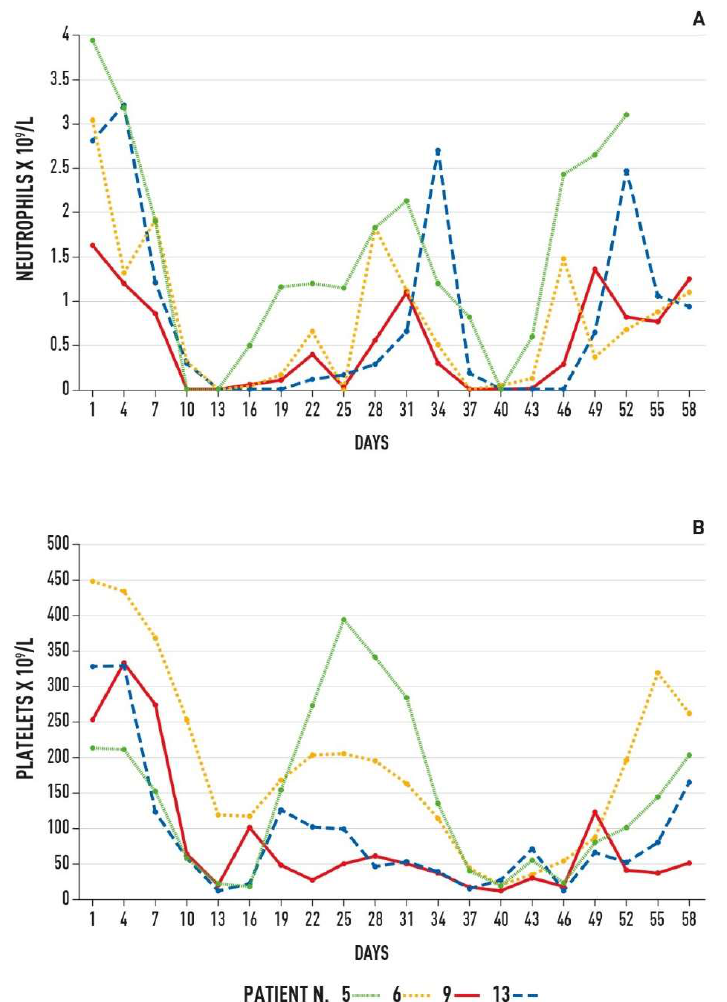
Figure 3. Hematologic toxicity of four patients with more extensive bone marrow infiltration. Time course of neutrophil ( A ) and platelet ( B ) values during and after treatment. Only patient number 9 was not responsive to treatment.